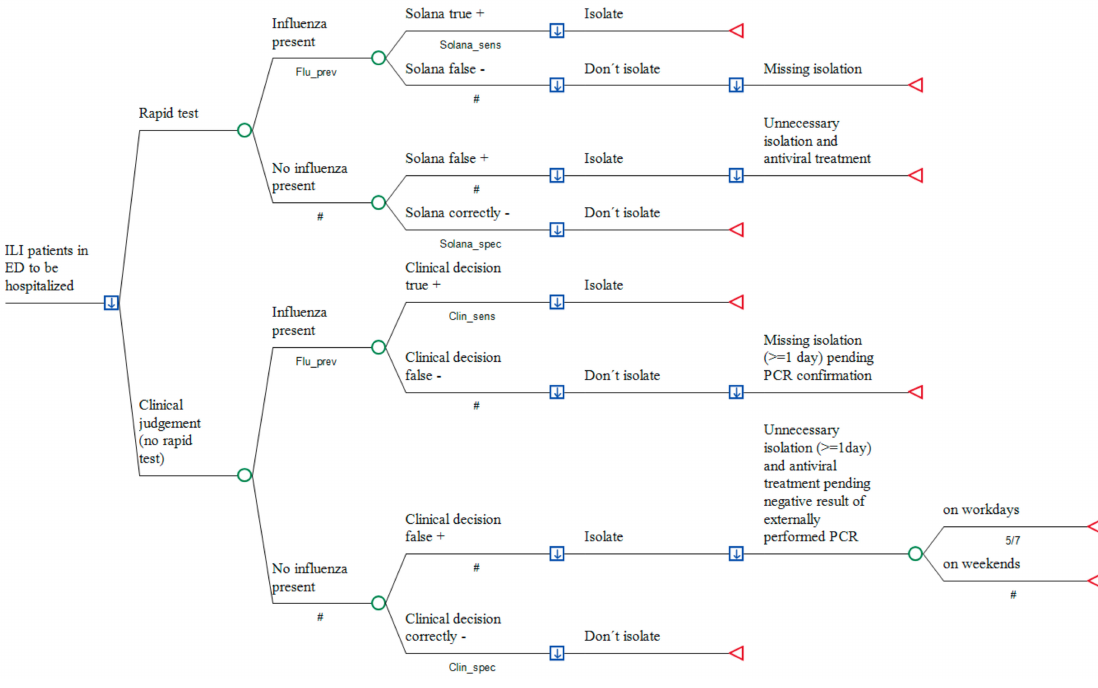
Figure 1. Real-time testing versus the conventional approach in influenza suspects prior to hospitalization. A decision node (square) indicates a choice facing the decision maker or the consequences of a decision. Branches from a change node (circles) represent the possible outcomes of an event; terminal nodes (triangles) denote the endpoints of a scenario and are assigned the cost of a prior series of actions and events. The arrows in the decision notes pointing downwards demonstrate that the optimal path of the model is that with the lowest total cost. #: Complementary probability (all probabilities of chance node’s branches to sum to 1.0); + : positive; − :